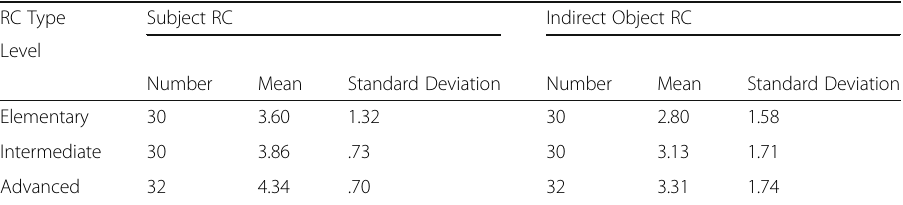
Table 4 Descriptive Statistics for the Relative Clause Test Scores for Subject and Indirect Object RC ’ s Across Three Levels RC Type